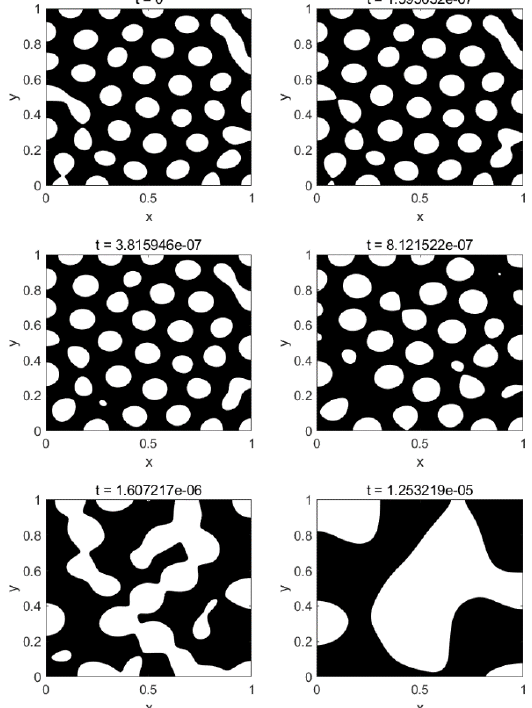
Figure 12. Patterns formed during the phase separation phenomena for the case where D = 10 5 , c o* = 0.3 and T * = 0.36. The asterisks were left out of the variables x , y , and t in the figure.